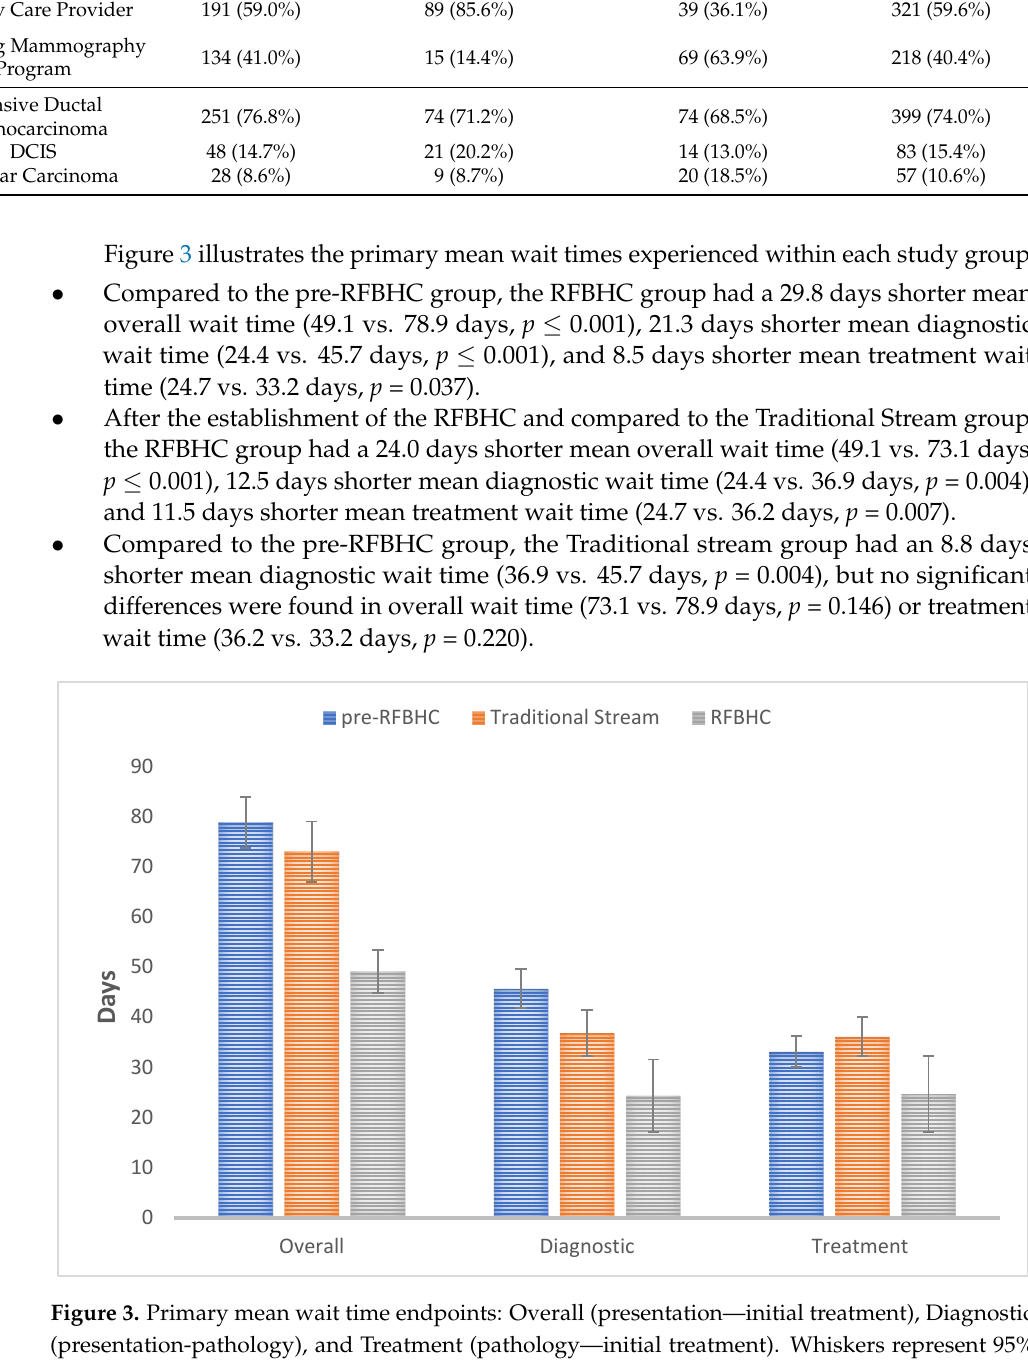
Figure 4. Secondary mean wait-time endpoints: presentation to diagnostic imaging (PI), diagnostic imaging to biopsy (IB), biopsy to pathology (BP), pathology to consult (PC), and consult to initial treatment (CT) for each study group. Compared to the pre-RFBHC group, the RFBHC group had improved statistical com- pliance with 4 of the 5 provincial and national breast cancer wait time standards included in this study (Table 3). Conversely, compared to the pre-RFBHC group, the Traditional Stream group had poorer compliance with the Pan-Canadian Standard for wait time from